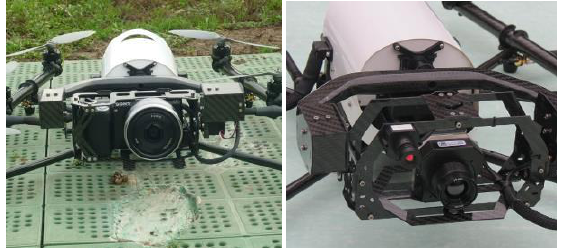
Fig. 6. Cameras (RGB and TIR) mounted on the Falcon that were used for this